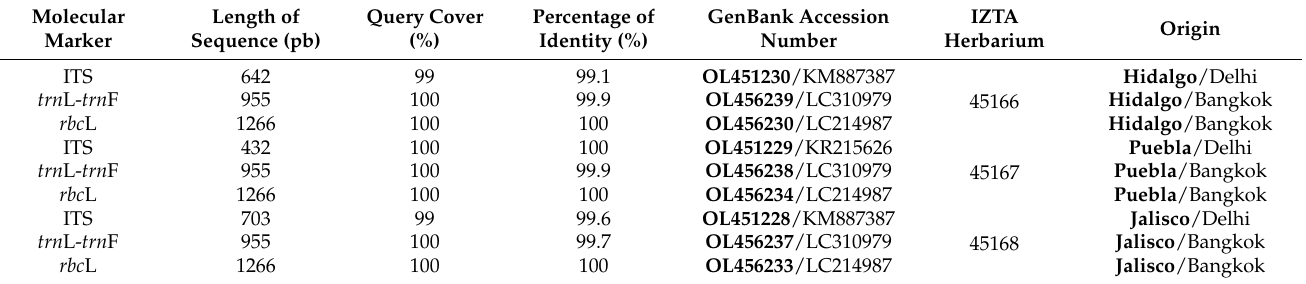
Table 3. Taxonomic identification of B. monnieri from Mexico using molecular marker sequences compared to reference materials.